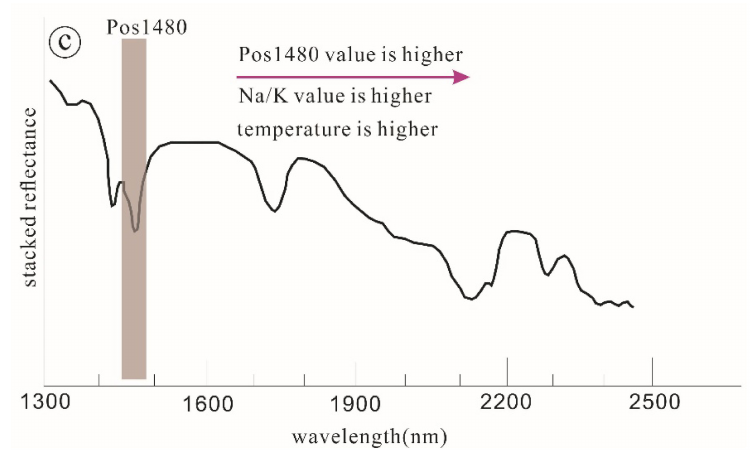
Figure 2. Schematic showing the correlation between the shift of diagnostic absorption peak, mineral chemistry, and controlling factors. ( a )—correlation of the Pos2200 value, the Al content, temperature, the pH value, and the IC value of sericite; ( b )—correlation of the Pos2250 value, the Fe/Mg value, and temperature of chlorite; ( c )—correlation of the Pos1480 value, the Na/K value, and temperature of